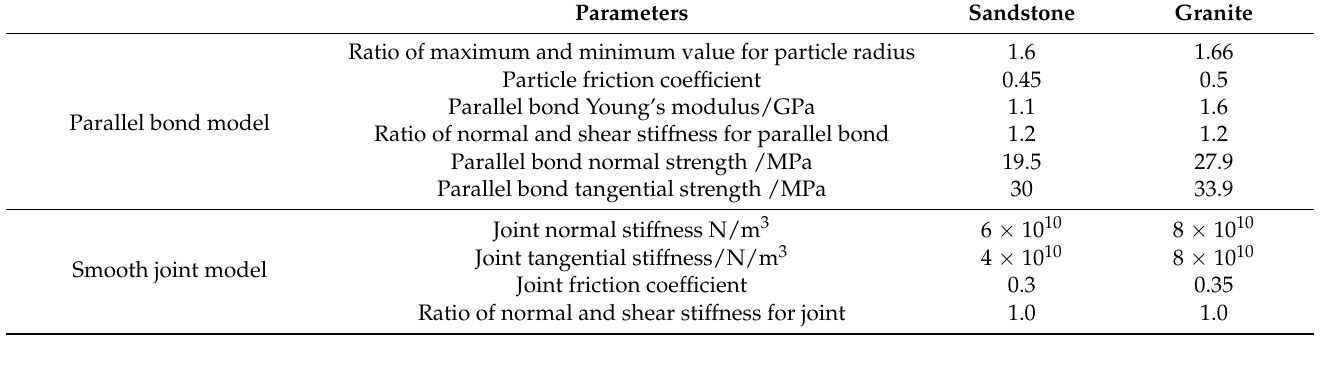
Figure 9. Numerical results of sandstone specimens: ( a )